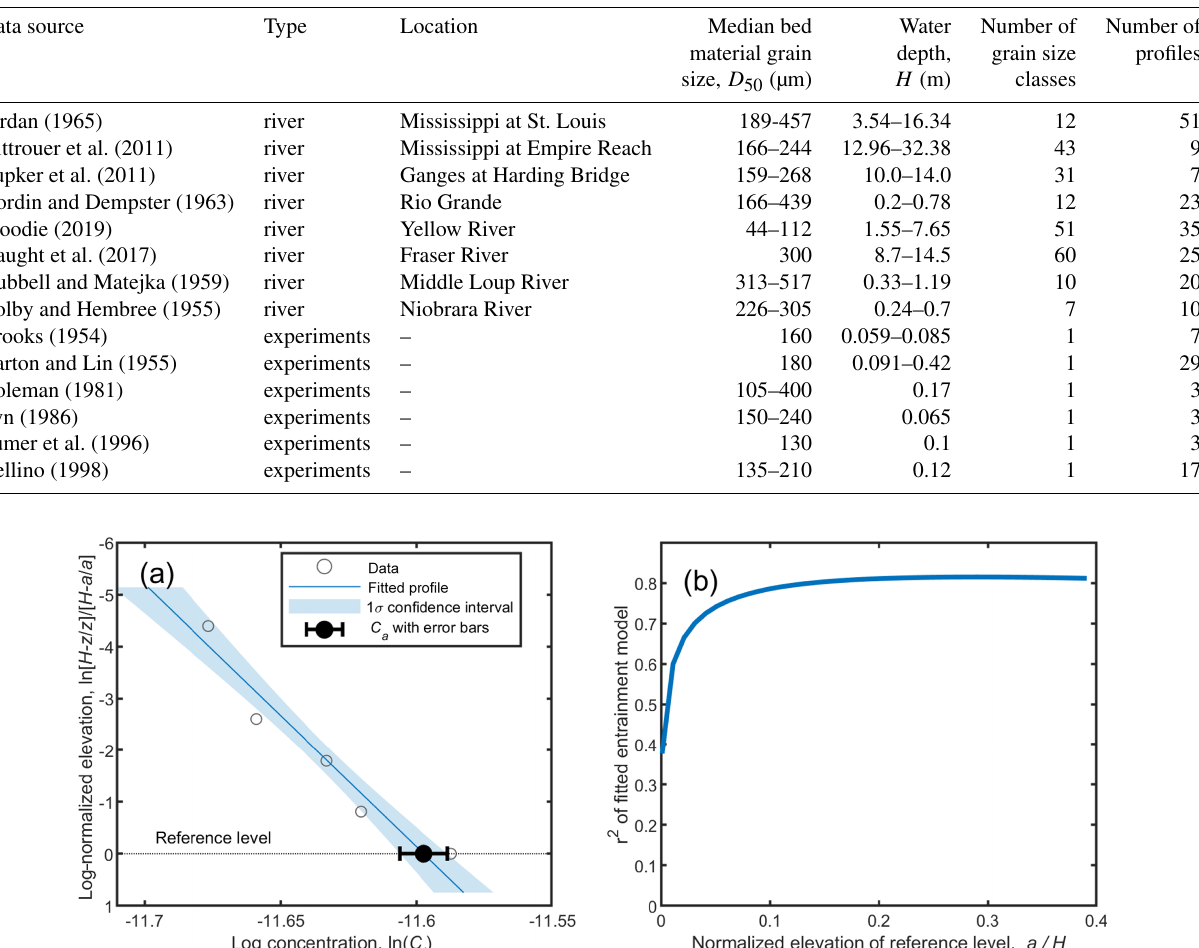
Table 3. Summary of experimental and field datasets included in the database.